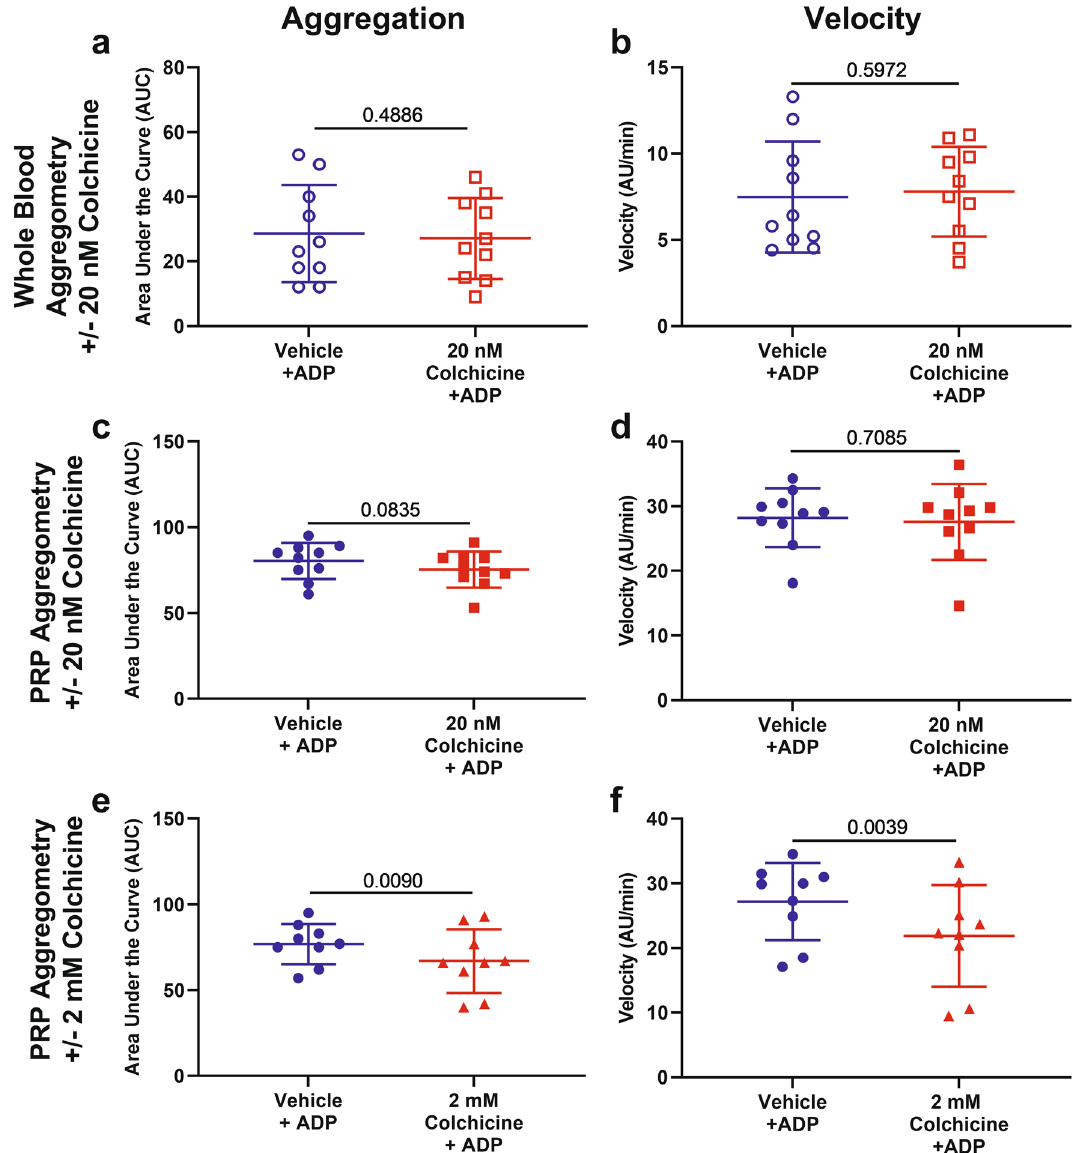
determined by paired t test to vehicle control. Data presented as mean ±